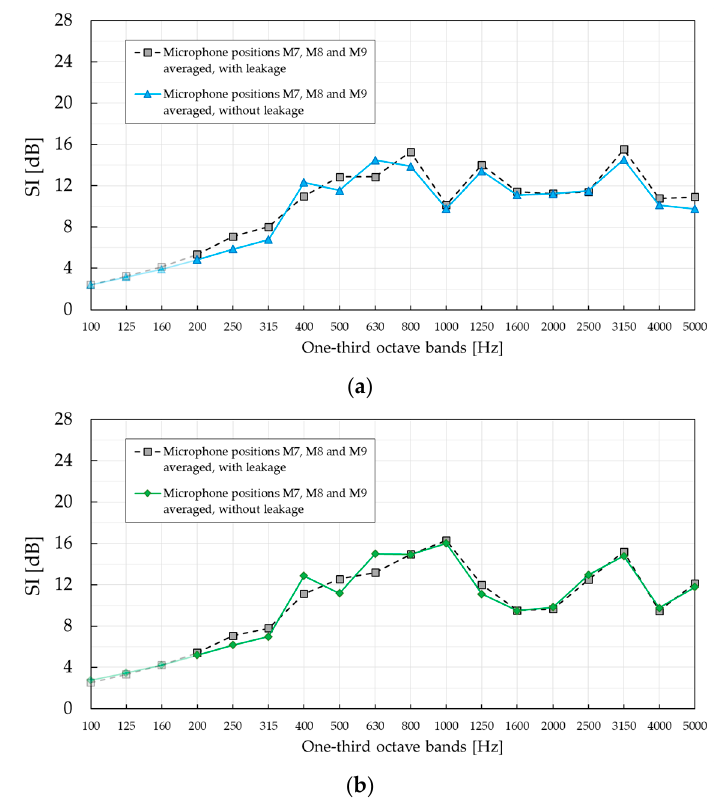
Figure A2. Influence of leakage under the barrier on SI values in the same measurement setup. The SI values are averages of the lowest three microphones (M7, M8, and M9) in the microphone grid. ( a ) Sound insulation index SI , configuration A . ( b ) Sound insulation index SI , configuration B .